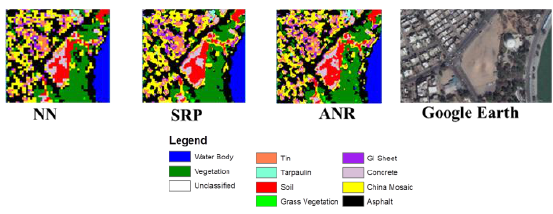
Figure 5. Visual Examination of SAM Classified Outputs